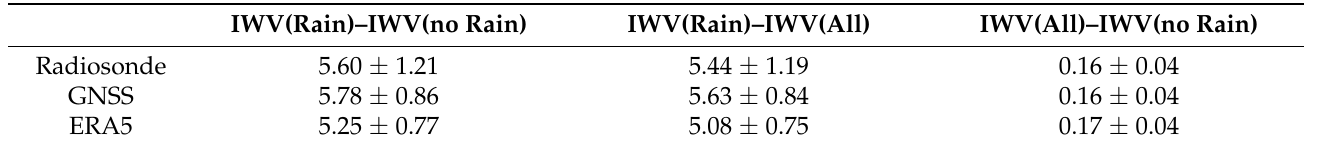
Table 1. Mean differences of IWV (mm) and their standard deviations derived for the different atmospheric states at Payerne using the monthly means of Figure 2. Rain periods are indicated by precipitation rates > 0.1 mm/10